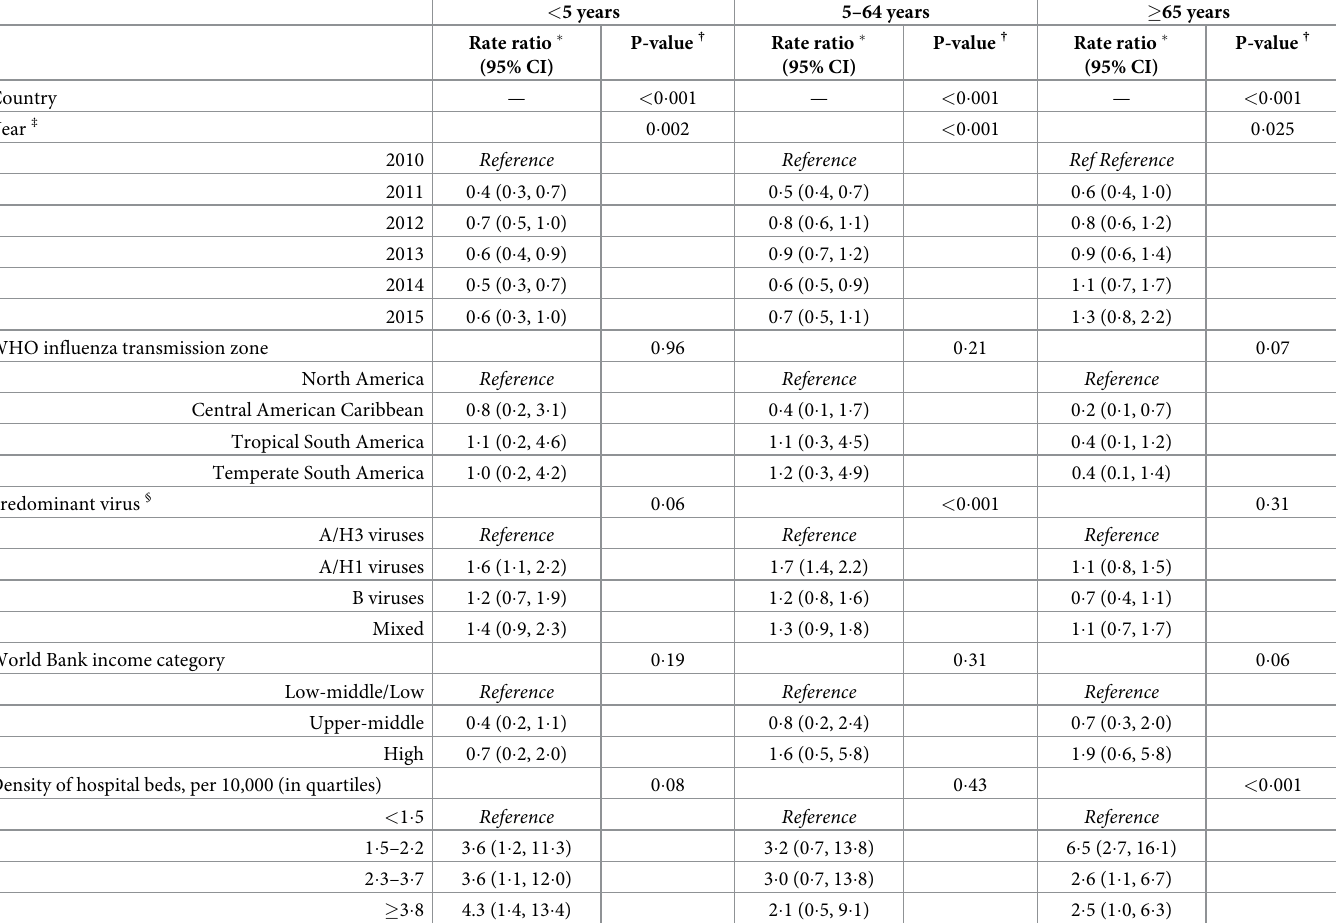
Table 2. Bivariate association between influenza-associated respiratory hospitalization rates and predictive covariates among 16 countries in the Americas partici- pating in the analysis, 2010–2015.